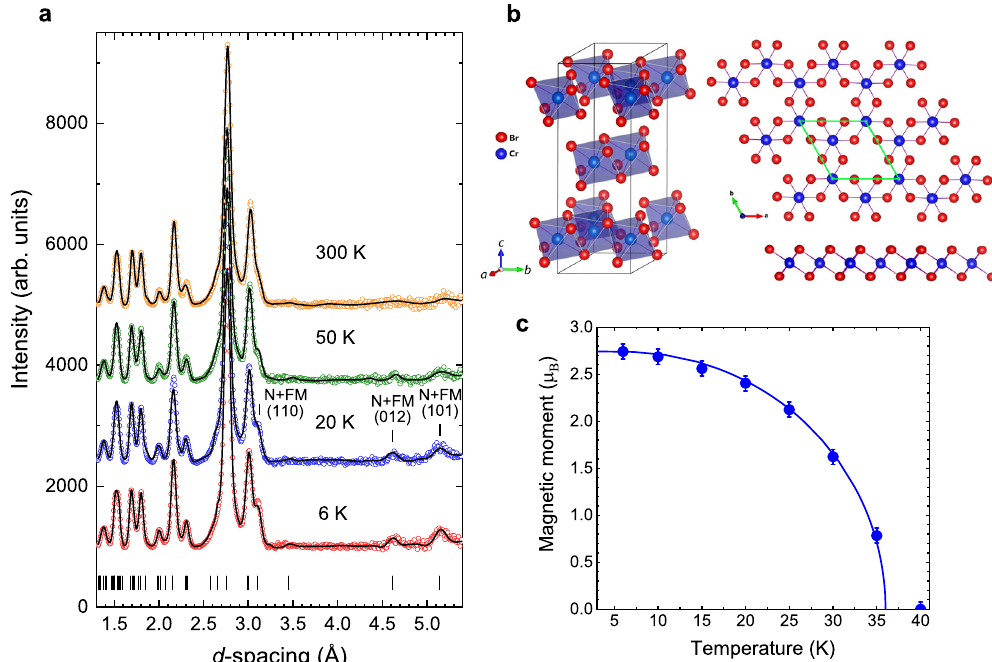
Fig. 1 Neutron diffraction patterns and crystal structure of CrBr 3 . a Neutron diffraction patterns of CrBr 3 measured at selected temperatures and re fi ned by the Rietveld method. The experimental points and calculated pro fi les are shown. The ticks below represent the calculated positions of the structural peaks of rhombohedral phase of CrBr 3 for selected temperatures. The characteristic peaks with magnetic scattering contribution superimposed on nuclear scattering contribution are marked as “ N + FM ” and their ( hkl ) indexes are given. b The rhombohedral structure of van der Waals crystal CrBr 3 of R 3 symmetry. The unit cell ( a ), top view ( b ) and side view of a single layer ( c ) are shown. c The Cr 3 + - ordered magnetic moment as function of temperature, fi tted by the expression (1).